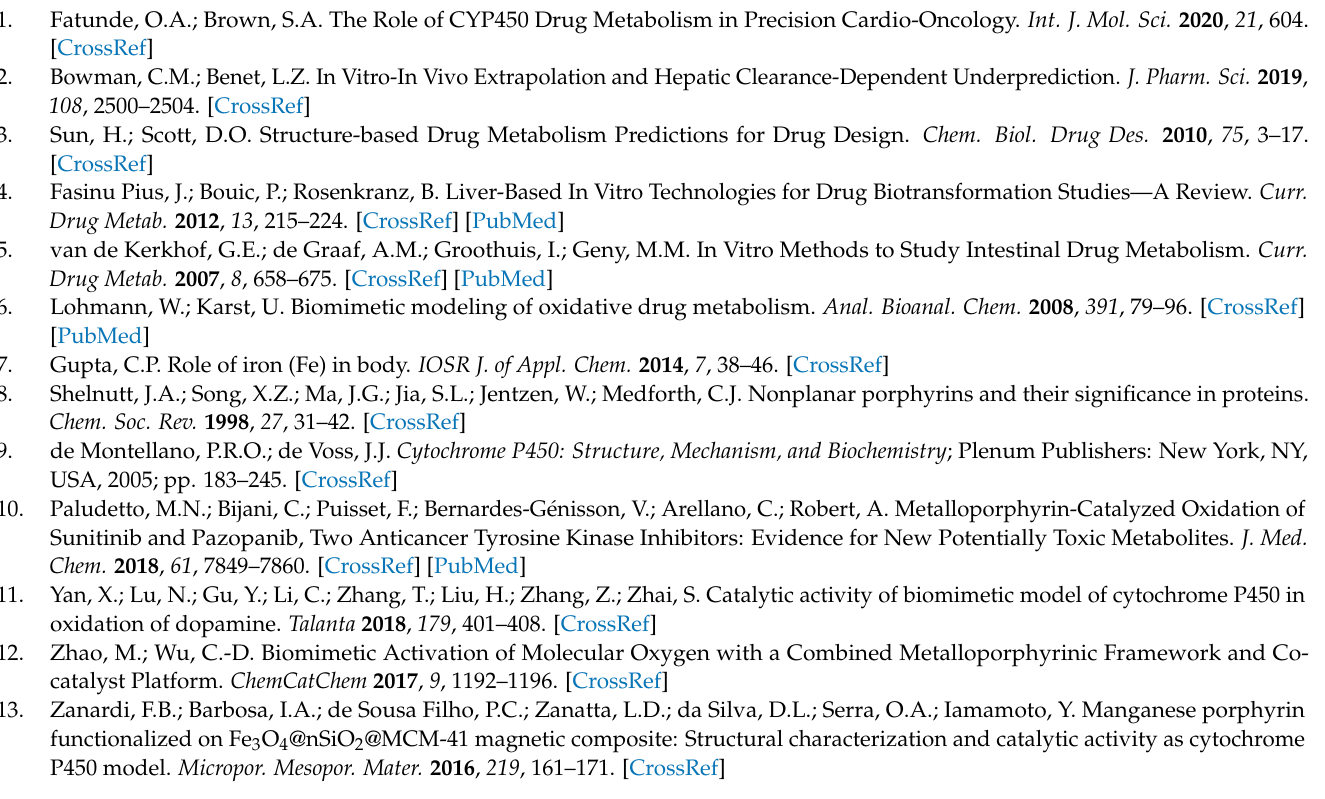
Figure S7: MS spectra of M2 metabolite, mono-oxidized metabolite of CQ. Figure S8: MS spectra of M3 metabolite, didesethyl-chloroquine (DDCQ). Figure S9: MS spectra of M4 metabolite, mono- oxidized metabolite of M3 . Figure S10: MS spectra of M5 metabolite, oxidative hydroxymethylated derivative of M1 . Figure S11: MS spectra of M6 metabolite, oxidative dehydrogenated derivative of M5